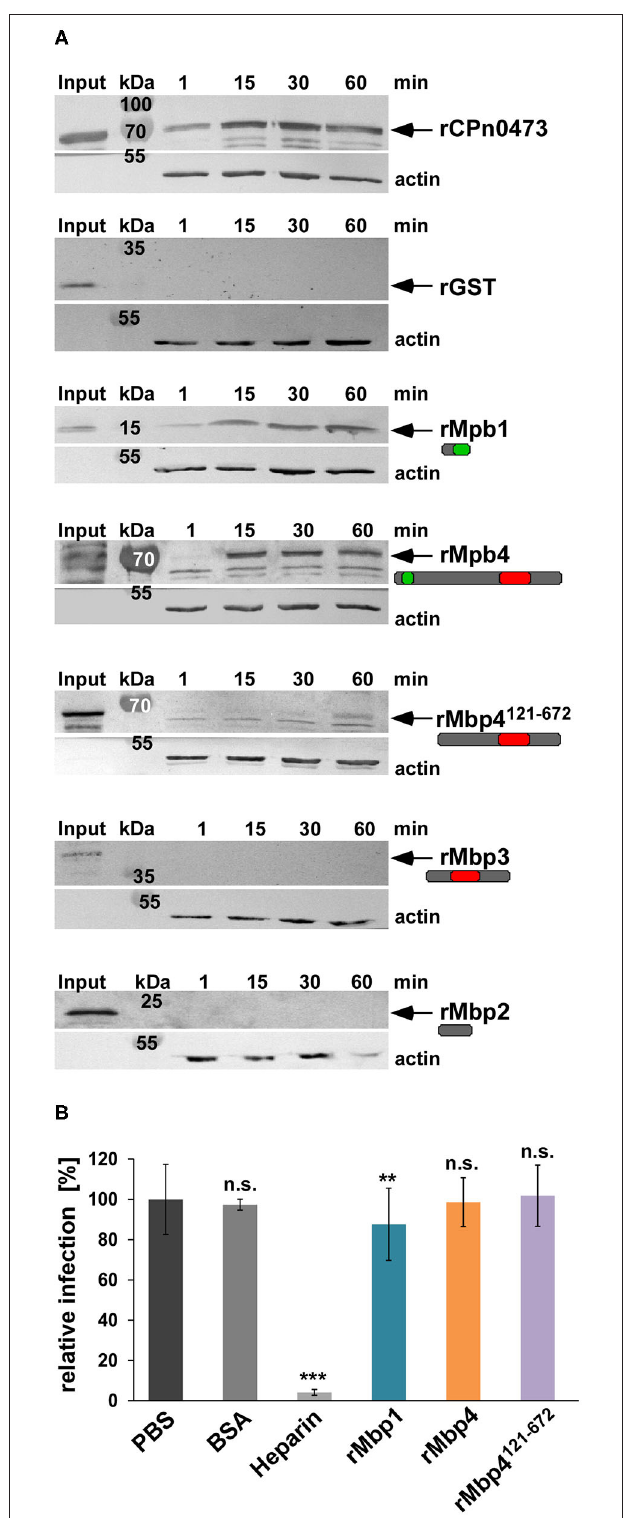
FIGURE 7 | The DUF575 enables cluster proteins to adhere to the plasma membrane. (A) Adhesion assay of His-tagged recombinant proteins to HEp-2